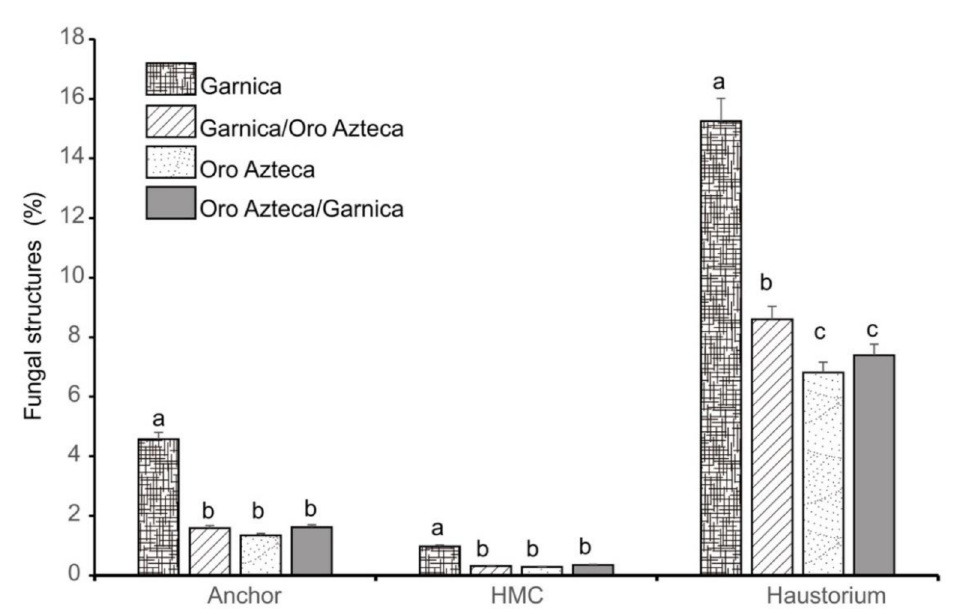
Figure 2. Global comparison of the presence of fungal structures (anchors, haustorial mother cells and haustoria) in each of the conditions evaluated; (HCM) haustorial mother cells. Different letters indicate significant differences by a Tukey-Kramer adjustment ( α = 0.05).